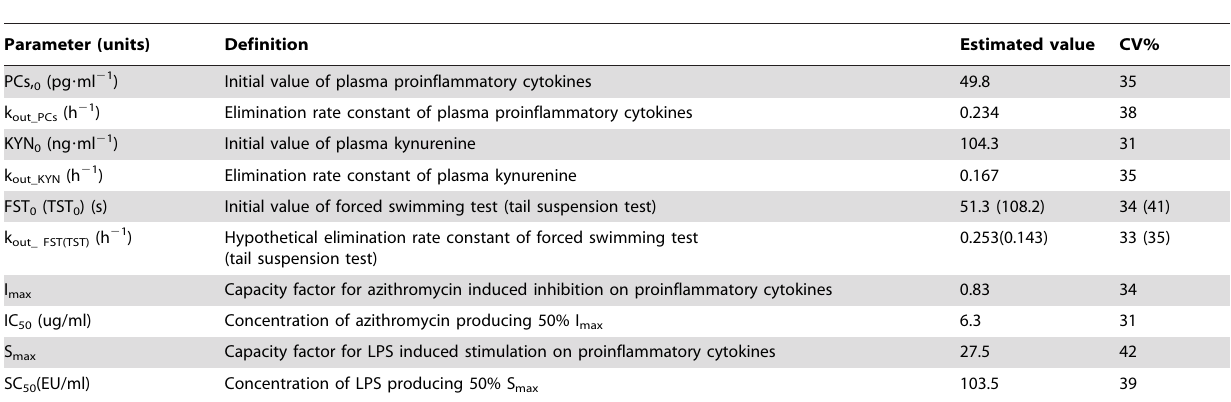
Table 3. Parameter Estimates for the LPS-Induced Depressive like Model and Azithromycin Pharmacodynamics.